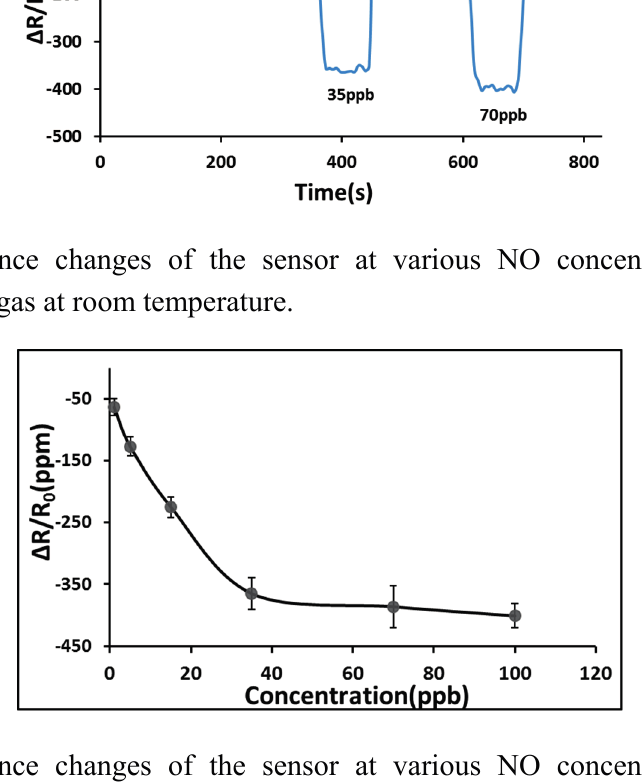
Figure 8. Resistance changes of the sensor at various NO concentrations using dry nitrogen as carrier gas at room